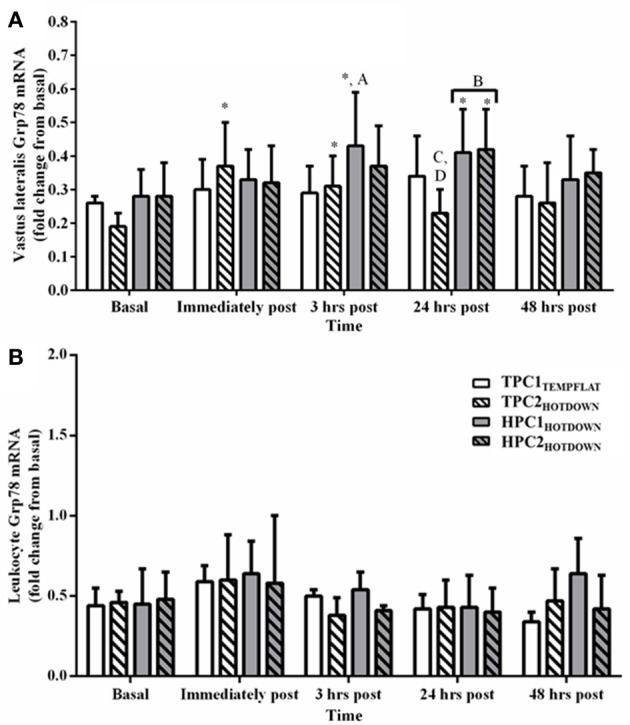
Grp78 mRNA response immediately before, immediately post, 3 h post, 24 h post, and 48 h post exercise in the Vastus lateralis (A) and Leukocytes (B). * Increased (p < 0.01) compared to basal. * Increased (p < 0.01) compared to basal. A, increased (p = 0.031) during HPC1HOTDOWN compared to TPC1TEMPFLAT. B, increased (p < 0.001) during HPC compared to TPC. C, decreased (p = 0.006) during TPC2HOTDOWN compared to HPC2HOTDOWN. D, decreased (p = 0.01) during TPC2HOTDOWN compared to TPC1TEMPFLAT. Data presented as median ± interquartile range.